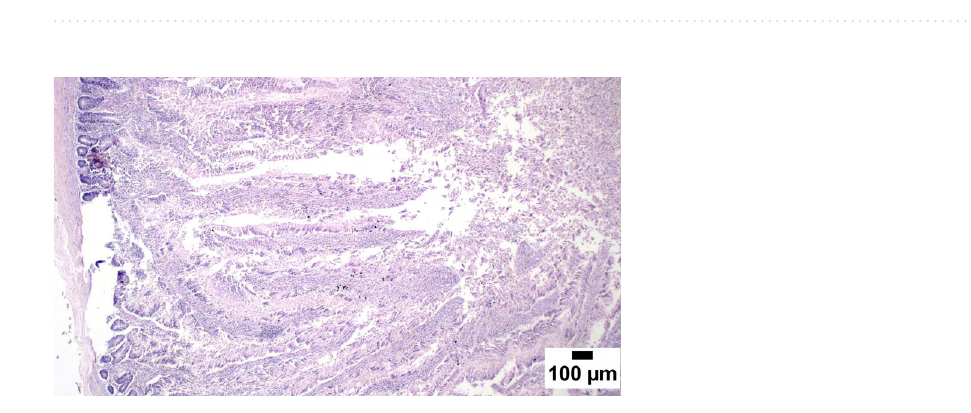
Figure 1. Photomicrograph of the duodenum, A group at 35 days showing normal histology of intestinal mucosa (H&E).